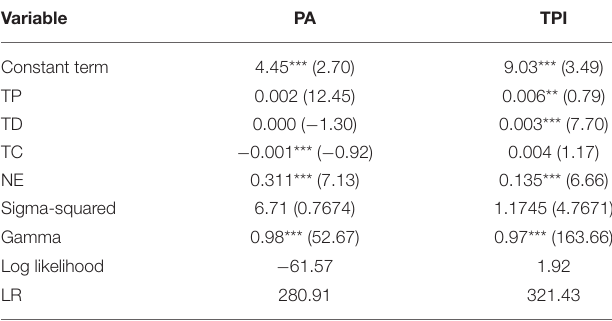
TABLE 3 | Regression adjustment results of second